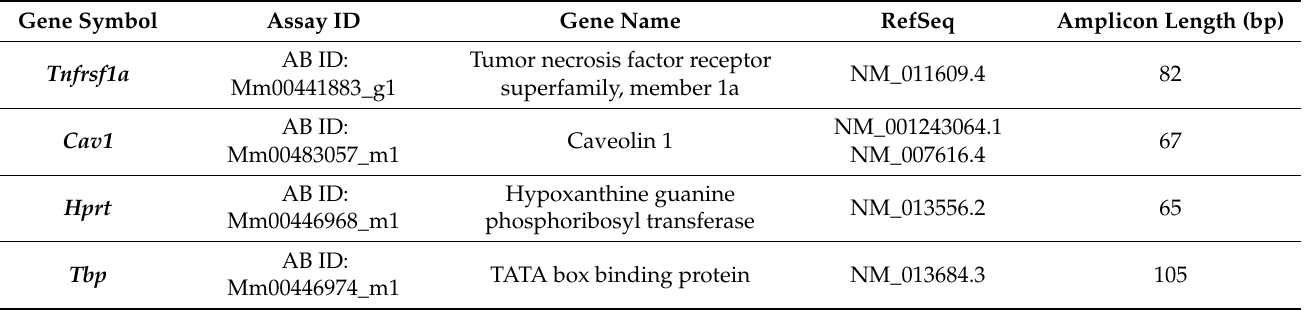
Table 1. The table shows the data on used primers: Gene symbols, assay IDs, gene names, GenBank reference sequence accession numbers, and amplicon lengths